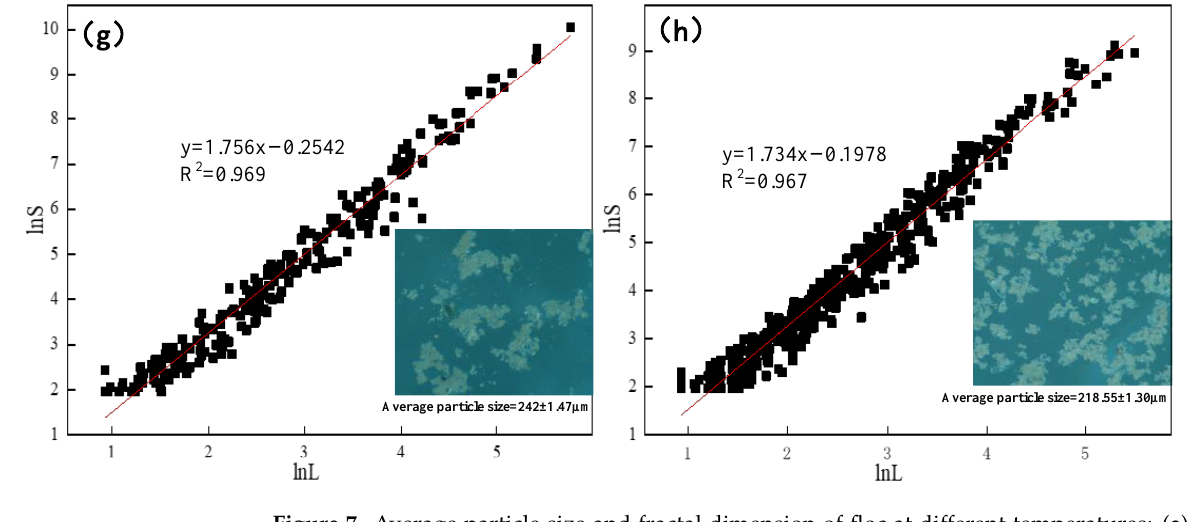
Figure 7. Average particle size and fractal dimension of floc at different temperatures: ( a ) 10 °C, ( b ) 20 °C, ( c ) 30 °C, ( d ) 40 °C, ( e ) 50 °C, ( f ) 60 °C, ( g ) 70 °C, ( h ) 80 °C.